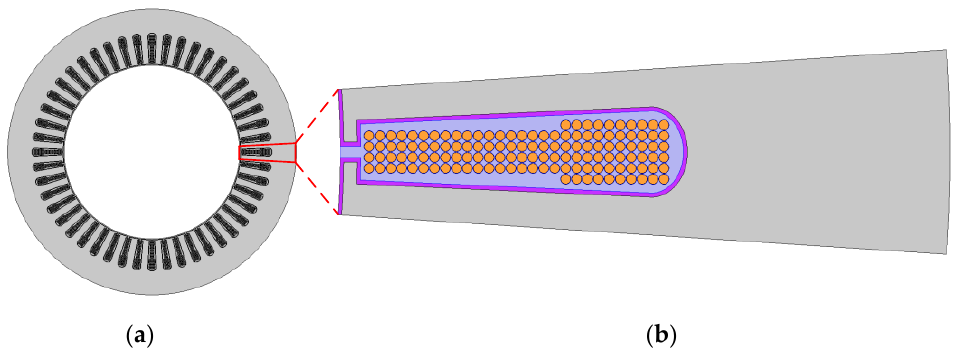
Figure 9. FEM model geometry implemented in COMSOL Multiphysics; ( a ) complete 48-slot stator model; ( b ) one slot model.